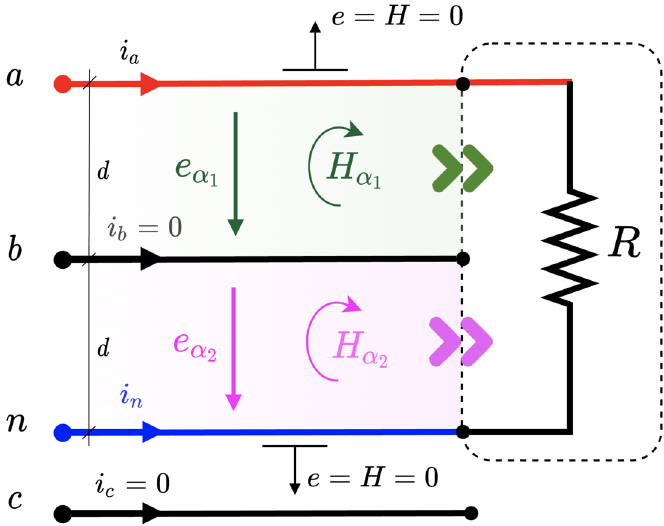
Figure 8. 4-wire unbalanced 3-phase circuit with resistor between line a and neutral n and line b in between.